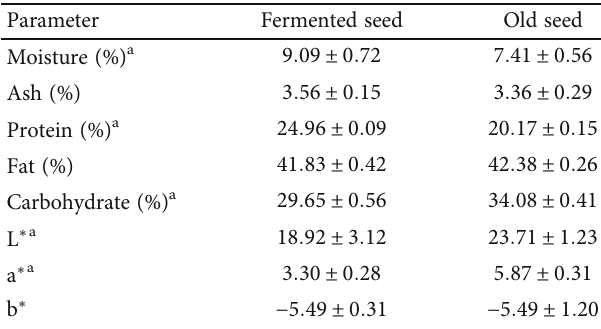
L ∗ indicates the level of brightness; a ∗ and b ∗ values indicate the color